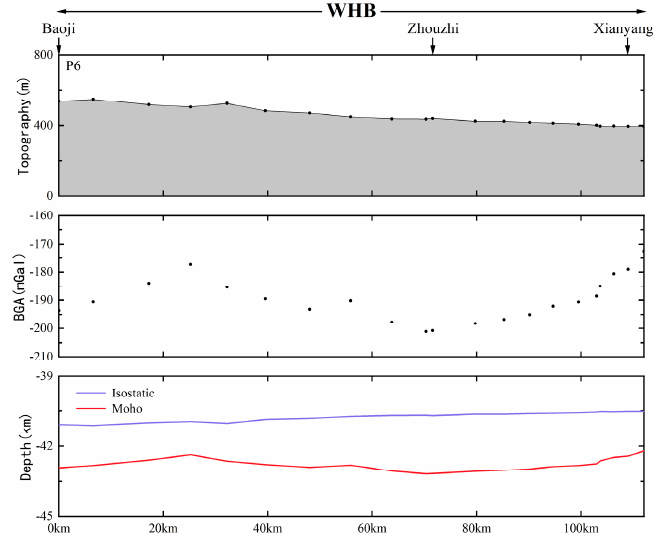
Figure 11. Topography, measured gravity anomalies, inverted Moho depth, and isostatic depth along profile P6 in Weihe Basin. Abbreviations are the same as those used in Figure 1.